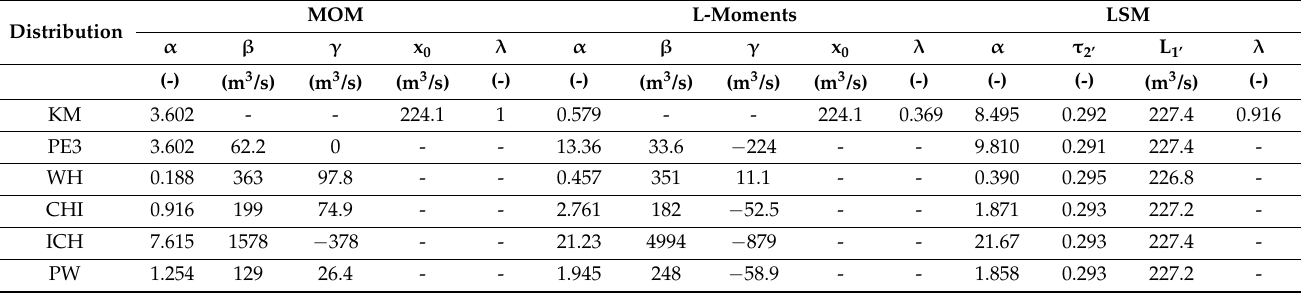
( c ) Figure 7. Comparison of estimation with ( a ) MOM, ( b ) L-moments, and ( c ) LSM. Table 8 shows the values of the distributions parameters for the three methods of estimation. Table 8. Estimated parameter values. Distribution